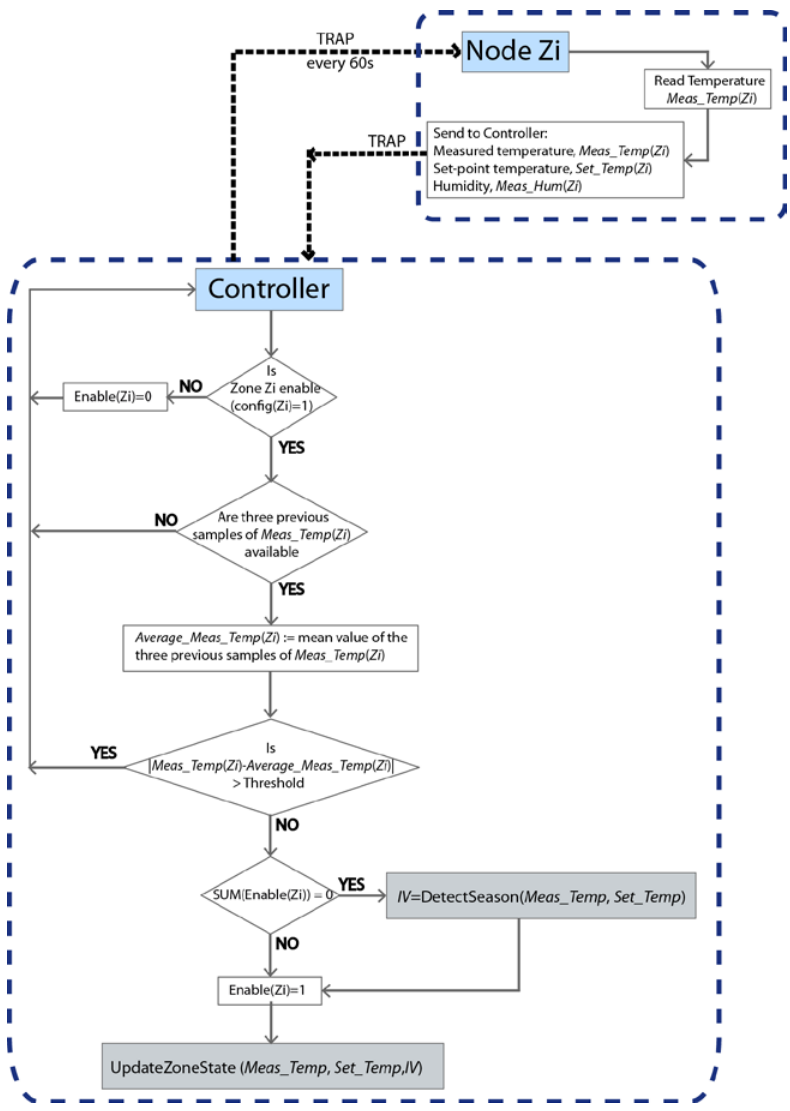
Figure 8. General flowchart of the temperature control algorithm.